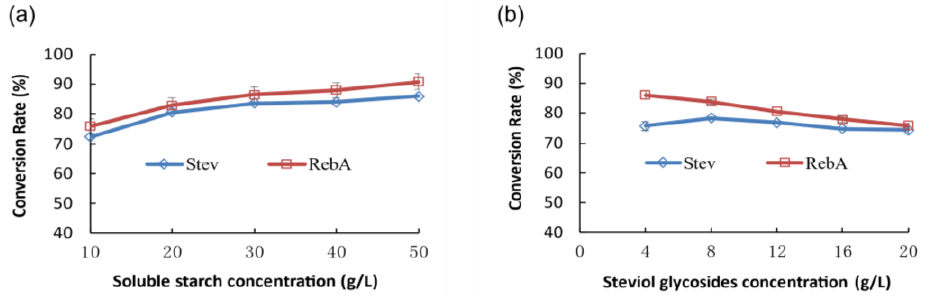
Figure 5. Effect of substrate concentration (soluble starch ( a ); steviol glycosides ( b )) on the conversion rate of Stev and Reb A to glucosylated steviol glycosides catalyzed by CGTase-13. Under optimum conditions, the conversion rates of Stev and Reb A reached 86.1% and 90.8%, respectively.